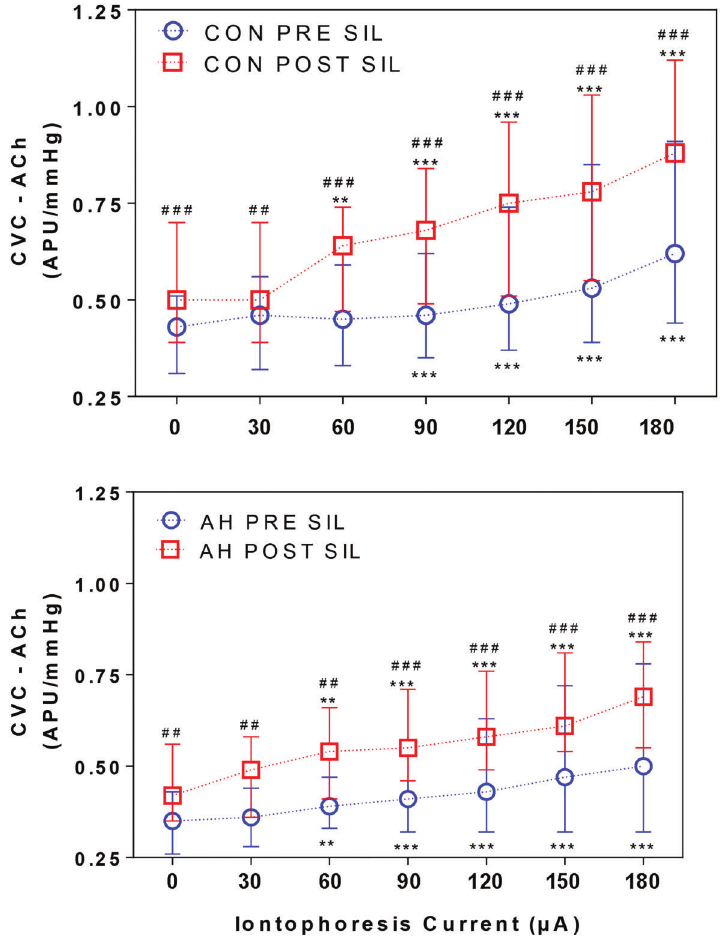
Figure 1. Effects of penile skin acetylcholine (ACh) iontophoresis on cutaneous microvascular conduc- tance (CVC), in arbitrary perfusion units (APU) divided by mean arterial pressure in mmHg in healthy volunteers (upper panel, CON; n=33) and hypertensive patients (lower panel, AH; n=34) before (PRE SIL) and after (POST SIL) oral sildena fi l (100 mg) administration. Data are reported as medians (interquartile range) and were analyzed using Wilcoxon ’ s test, the Mann- Whitney U-test or repeated measures analysis of variance followed by Dunnett ’ s multiple com- parison test when appropriate. **P o 0.01 and ***P o 0.001 compared with baseline values. ## P o 0.01 and ### P o 0.001 compared with PRE